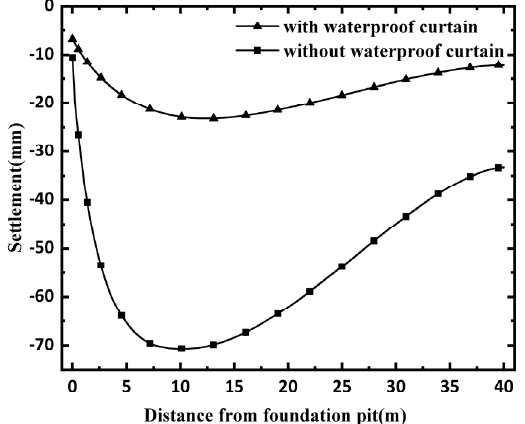
Figure 5. Influence of waterproof curtain on surface settlement outside the pit.